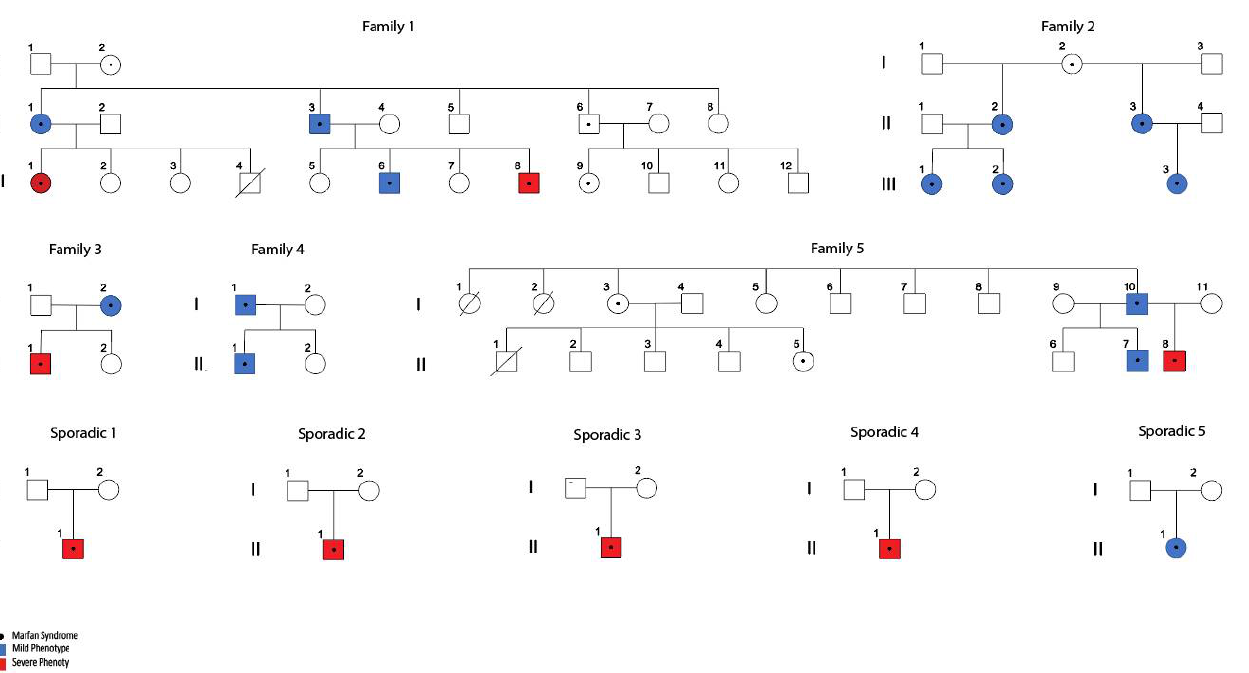
Figure 1. Familial and sporadic cases of MFS with significant variation in severity of their aortic phenotype. MFS clinical diagnosis was confirmed through identification of pathogenic variants in FBN1 (see Table 1). Stratification of patients was done as described in Supplementary Table